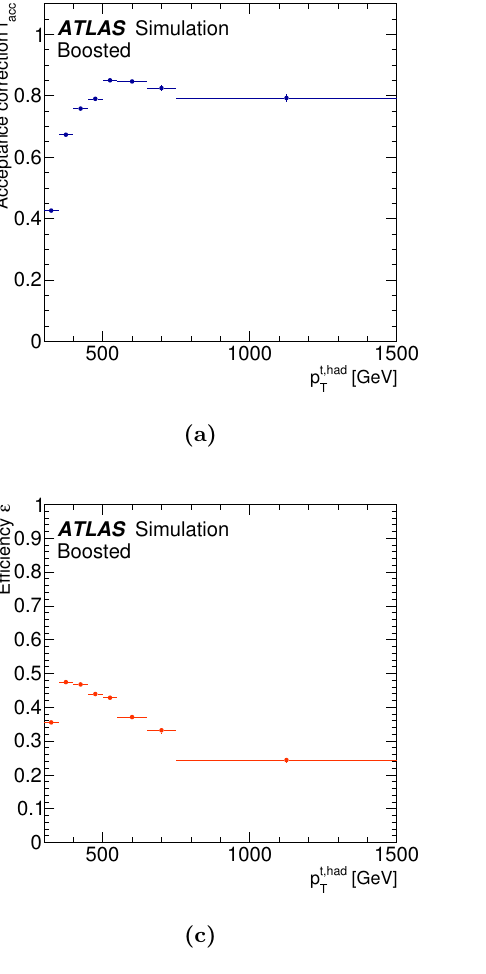
(cid:12) (cid:12) (cid:12) y t; had (cid:12) , and the e(cid:14)ciency correction for (c) the hadronic